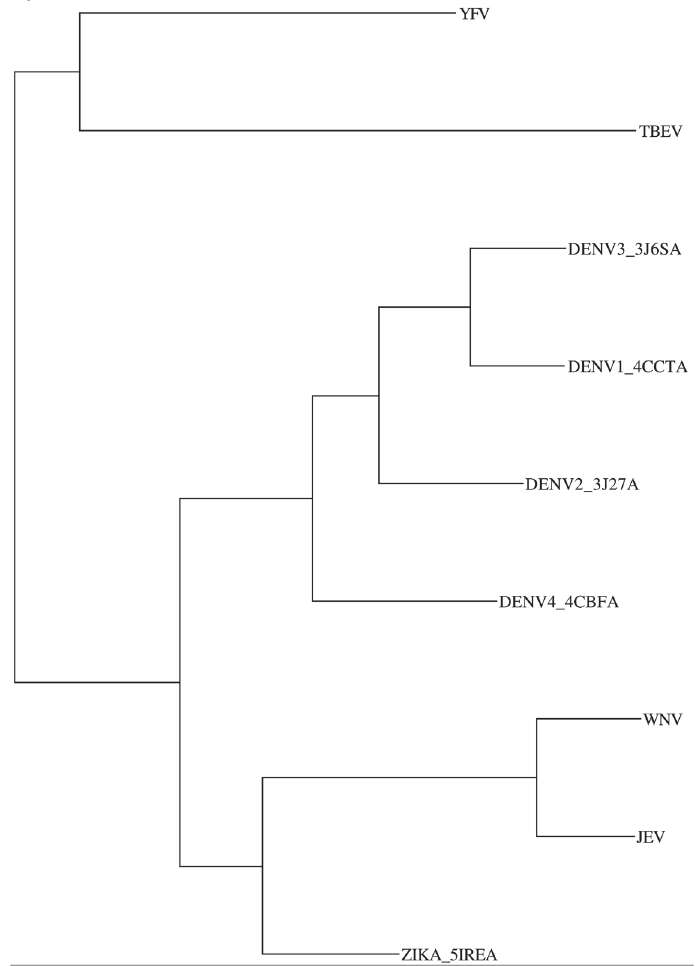
Supplementary Figure 1. Phylogeny of different flaviviruses based on the E-protein sequence alignment. Japanese encephalitis virus (JEV, GenBank Accid:AAZ17558.1), West Nile virus (WNV, GenBank Accid:ACH99530.1), Tick-borne encephalitis virus (TBEV, GenBank Accid:AEP25269.1), Yellow fever virus (YFV, GenBank Accid:AAA92696.1). TBEV and YFV are distantly related to DENV, ZIKV, JEV and